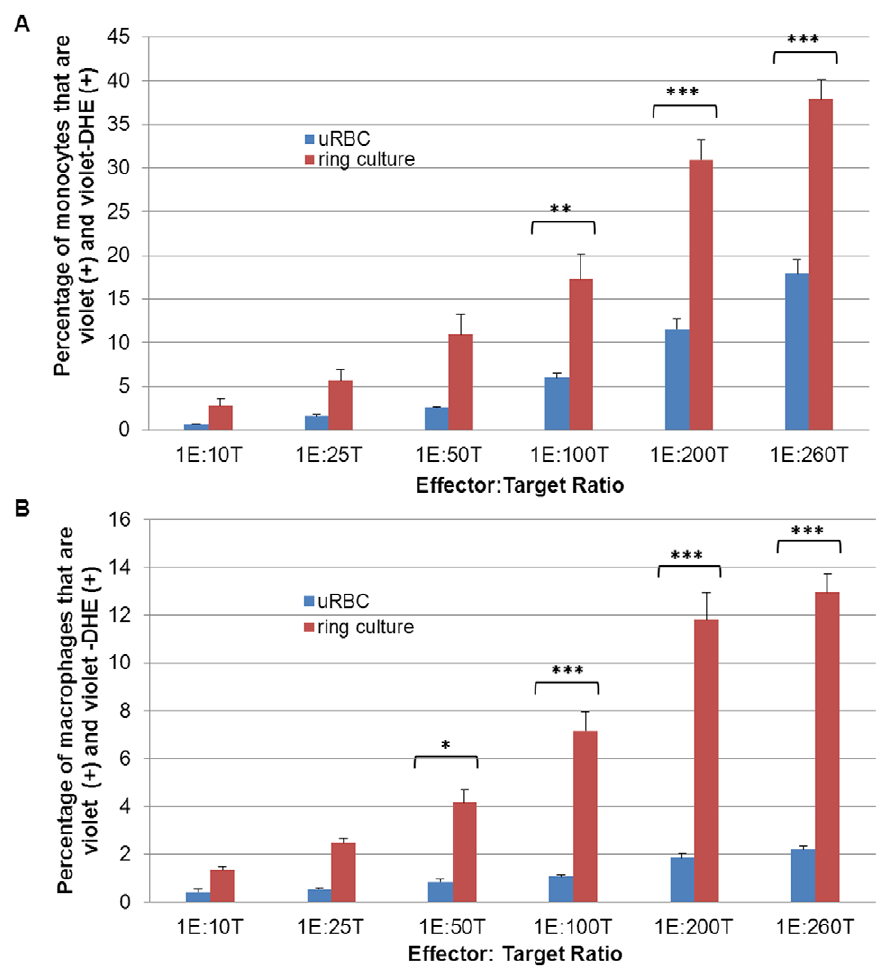
Figure 3. Optimisation of effector (THP-1) to target (erythrocytes) ratio. The effectors used in these experiments were ( A ) THP-1 monocytes, ( B ) PMA-differentiated THP-1 macrophages and the targets were fresh uninfected erythrocytes (uRBC) or ring-staged Plasmodium falciparum culture (ring culture) at 10% parasitemia. ____Percentage of effectors that have engulfed at least one erythrocyte (uninfected or infected) at effector : target (E:T) ratios from 1:10 to 1:260 after 4 h incubation at 37 u C with pure effectors as the control. The experiments were done in duplicates at least 3 times with data expressed as mean 6 SEM. Statistical analyses compared the number of effectors which had ingested erythrocytes from the uRBC culture with that from ring culture at the same E:T ratio. (*represents p , 0.05, **represent p , 0.005, ***represent p ,